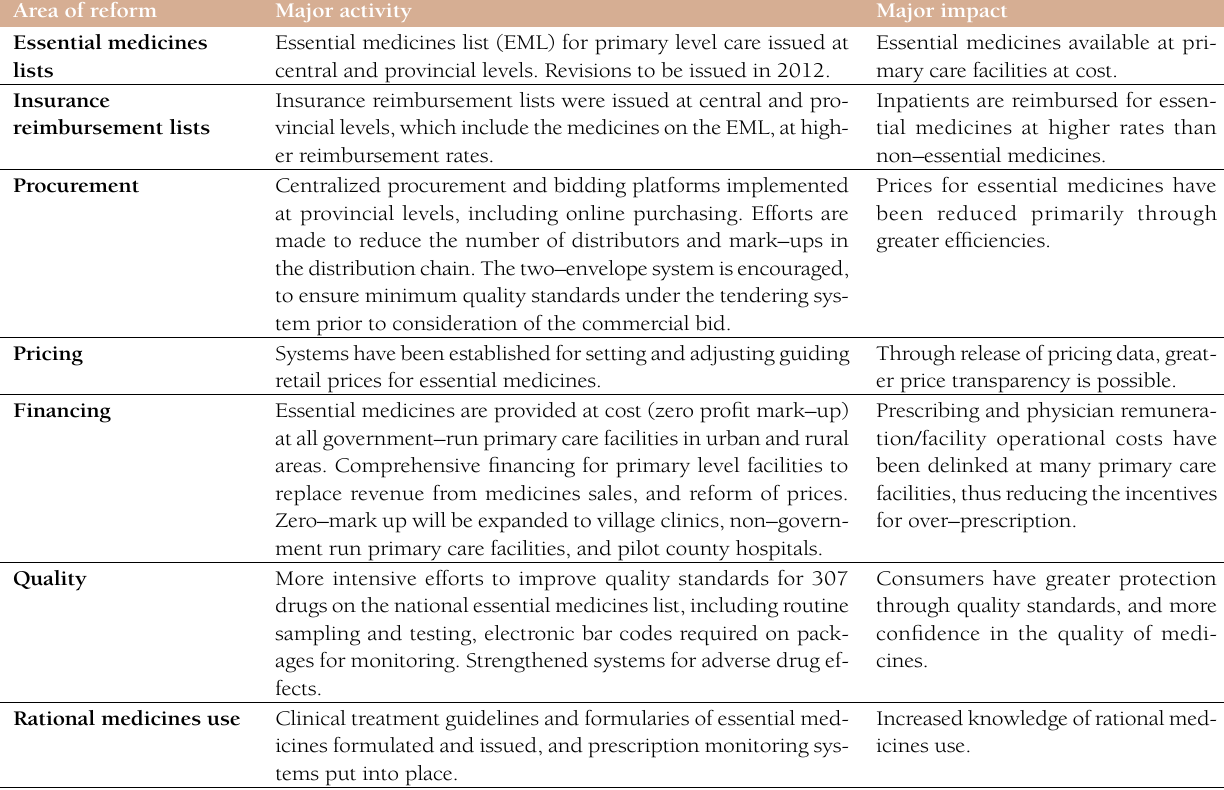
Table 2. National Health Care Reform in China: Summary of activities under the reform of the essential medicines